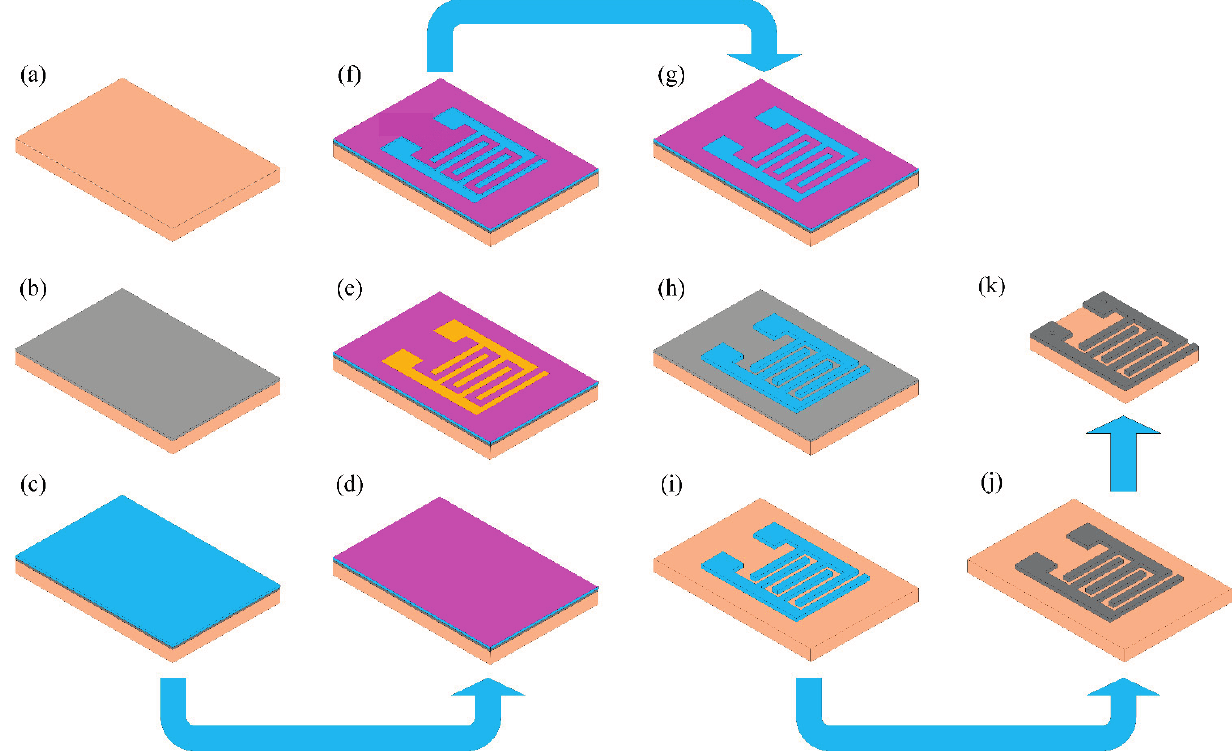
Figure 3. Step-by-step fabrication process of the interdigitated electrode: ( a ) polyimide substrate; ( b ) Cr layer on the polyimide substrate; ( c ) Cu layer; ( d ) photoresist layer; ( e ) placing the mask pattern on the photoresist layer; ( f ) transferring the mask pattern onto the photoresist layer; ( g ) depositing Cu via electroplating; ( h ) removing the photoresist; ( i ) removing the Cr layer; ( j ) depositing the Sn layer onto the Cu layer via electroplating; and ( k ) cutting the residual polyimide